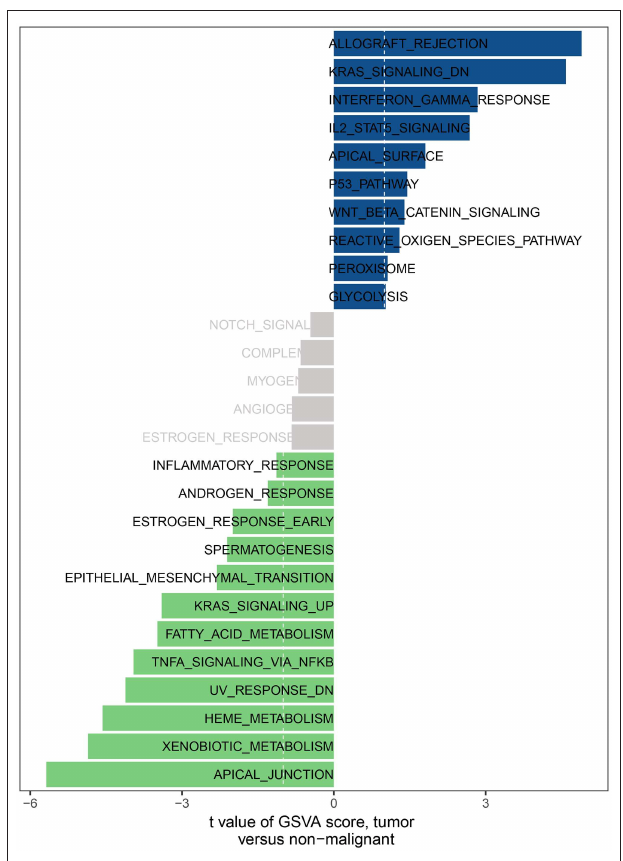
FIGURE 16 | The GSVA analysis for three HNC clusters.